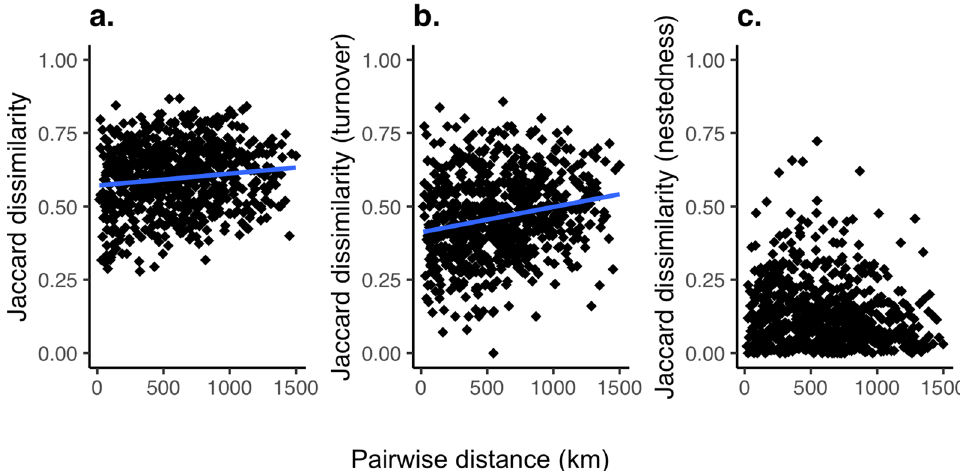
Figure 3. Pairwise β-diversity against river distance for all sites. β-diversity is calculated based on Jaccard dissimilarity where 0 would indicate identical communities. The blue line indicates the significant correlation using Mantel statistic: ( a ) Jaccard dissimilarity, Mantel statistic: 0.15, p < 0.05, ( b ) turnover, Mantel statistic 0.23, p < 0.005 and ( c ) nestedness, not significant. Figure produced using R studio, version 3.6.3 with the ggplot2 package.